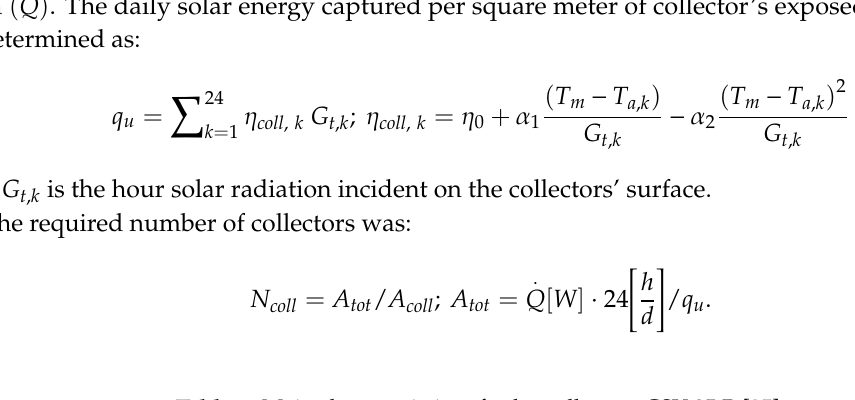
Table 3. Main characteristics of solar collectors CSV 35 R